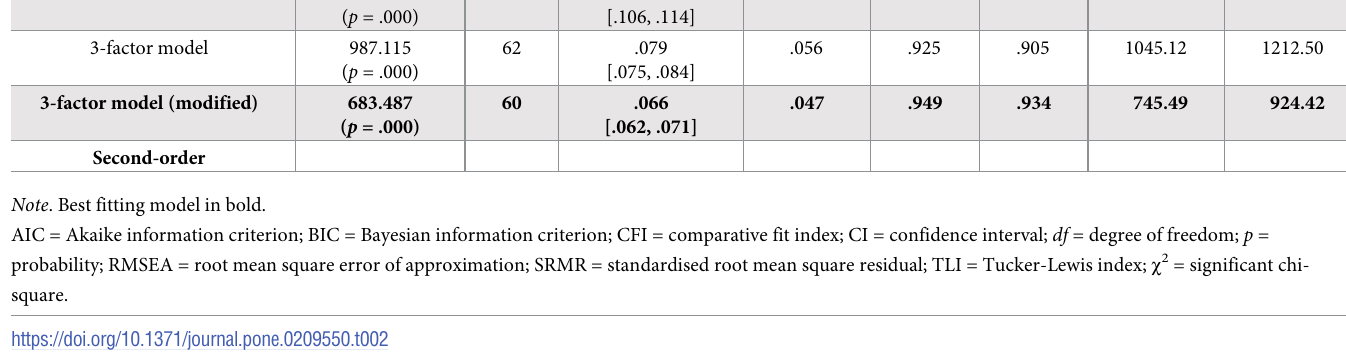
Table 2. Fit indices for the confirmatory factor analyses (CFA) models of the revised sense of coherence (SOC-R) scale.